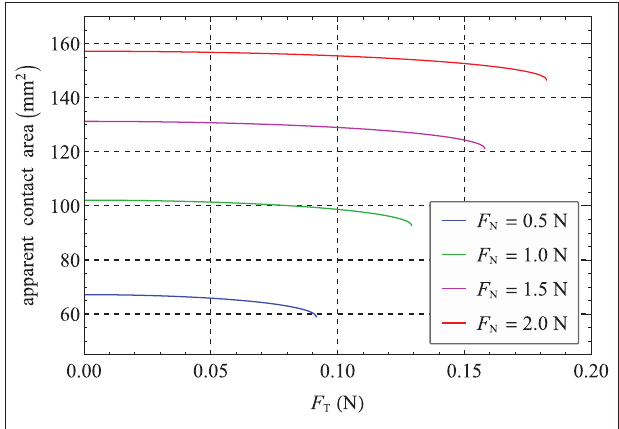
FIGURE 5 | Apparent contact area as a function of tangential load for different normal forces.